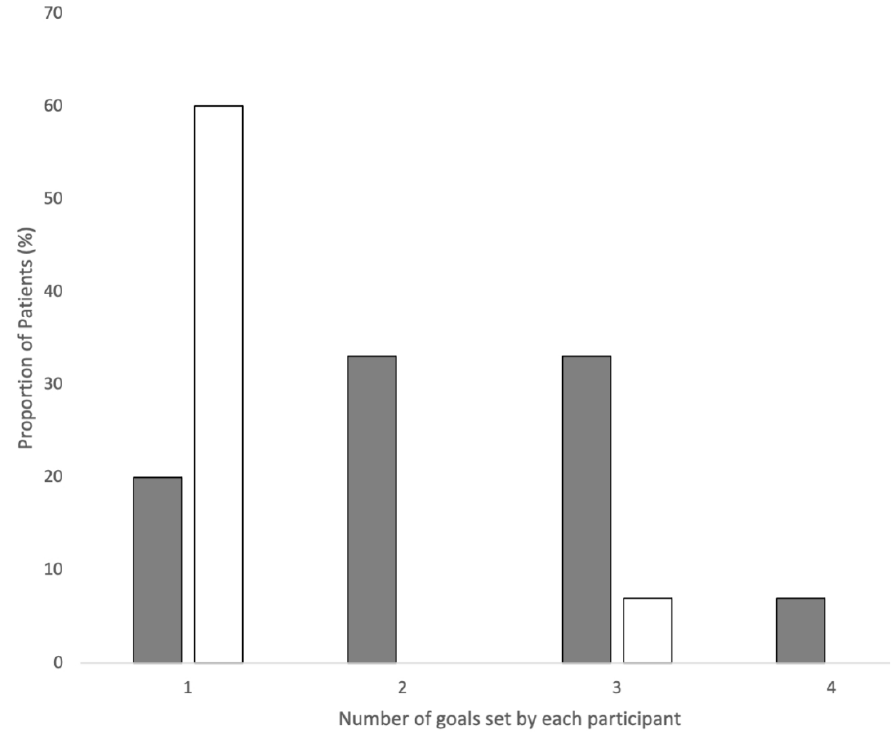
Figure 1. Frequency of patients setting one to four initial CVD prevention goals. Grey, behavioural goals; white, health measure goals.